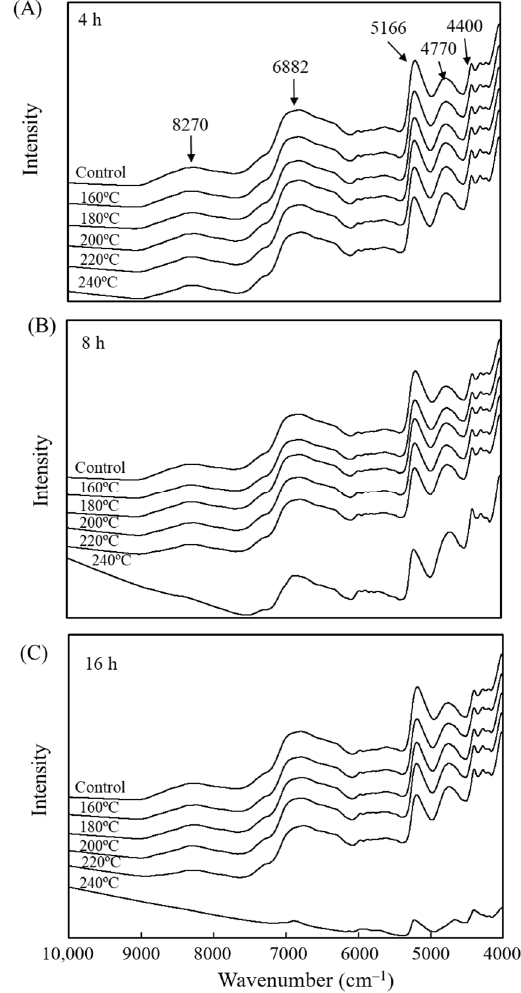
Figure 3. NIR spectra of luanta fir wood before and after VH treatment at different temperatures for ( A ) 4, ( B ) 8, and ( C ) 16 h.